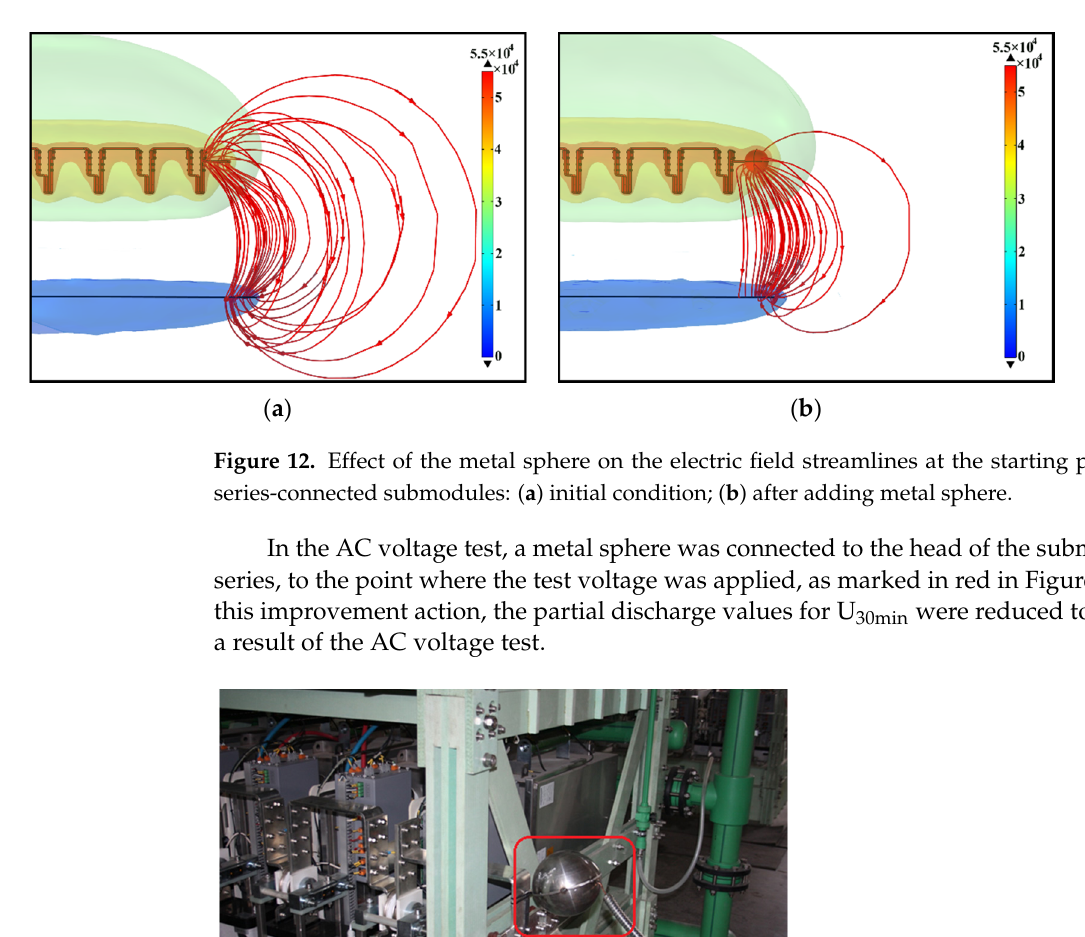
Figure 11. Metal sphere attached to the far end of the sub-modules.